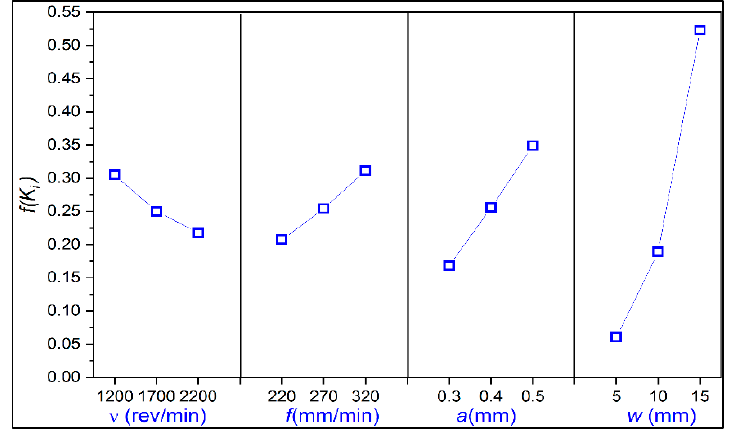
Figure 3. Level-wise aggregated f(K_i) score for each process parameter in case study 2.